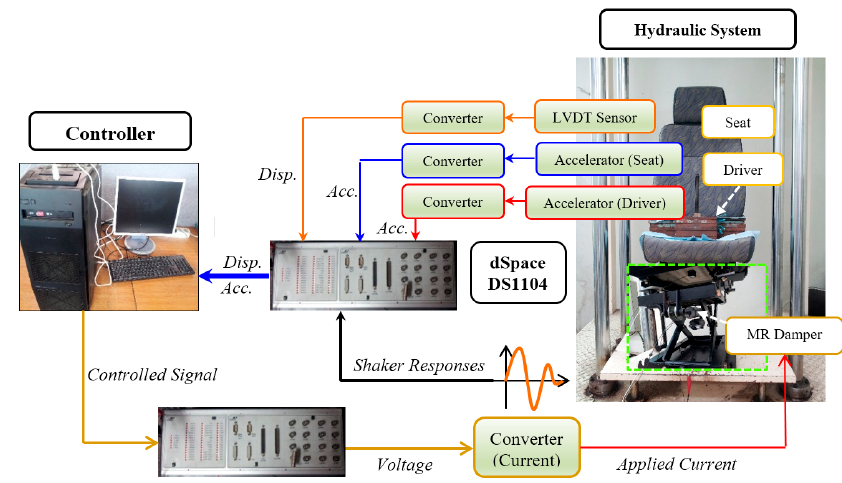
Figure 6. Experiment setup for vibration control of MR seat suspension system.